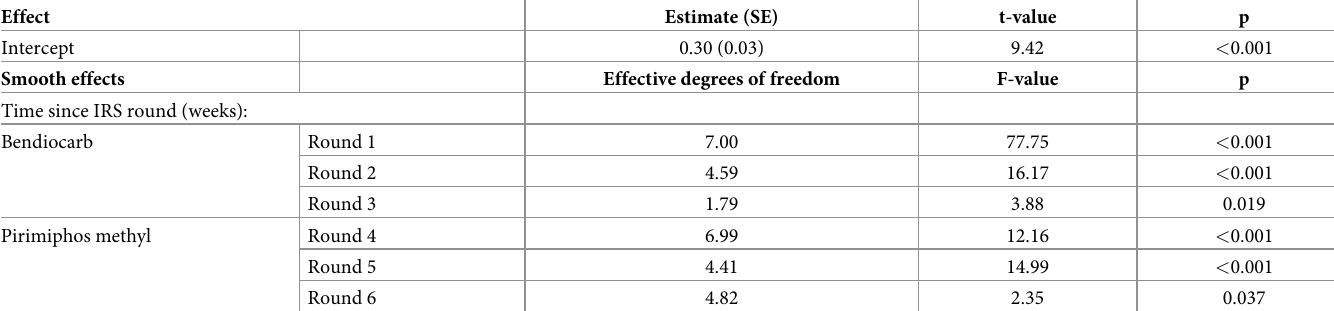
Table 2. Estimates of the fitted GAM model using B-splines.